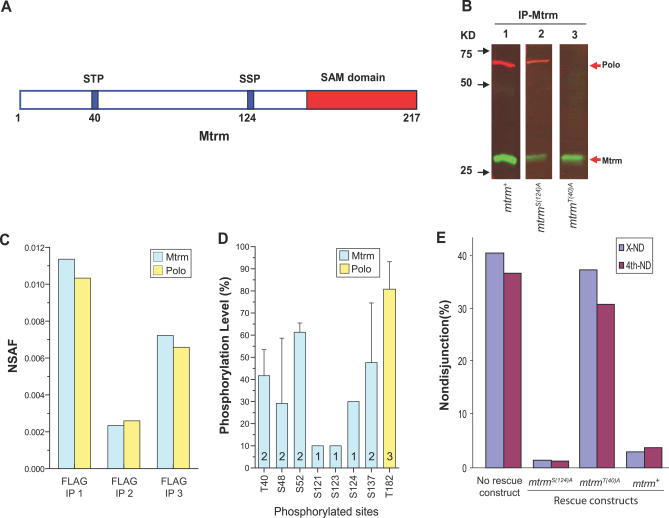
Mtrm Physically Interacts with Polo with a Stoichiometry of Approximately 1:1(A) Schematic depiction of the Mtrm protein. Mtrm has two potential PBD-binding sites, STP and SSP, with the central serine/threonine residue at 40 and 124, respectively, and a SAM domain at the C terminus. Two independent transgenes expressing mutated PBD-binding sites were generated: MtrmT(40)A, which disrupts the STP site and MtrmS(124)A, which disrupts the SSP site.(B) Mtrm and Polo physically interact as shown by coimmunoprecipitation experiments. An antibody to Mtrm precipitates Polo from wild-type ovary extracts (lane 1). Expression of the mutated PBD binding site constructs in a mtrm null background reveals that MtrmS(124)A does not ablate the Mtrm-Polo interaction (lane 2); however, MtrmT(40)A failed to bind Polo (lane 3), indicating that the STP motif is critical for the Mtrm-Polo interaction.(C) Three independent affinity purifications from ovarian extracts expressing a C-terminally 3× FLAG-tagged Mtrm were used for the MudPIT mass spectrometry assay. Among the reproducible and significant (p-value < 0.001) proteins identified in all three analyses, Polo was detected by multiple peptides and stands out as the only protein recovered at levels similar to those of Mtrm, as estimated by NSAF.(D) Phosphorylated sites detected in Mtrm (blue bars) and Polo (yellow bar) are shown. Modification levels are estimated based on local spectral count and averaged across the three immunoprecipitations. The underlined numbers in each bar represent the number of times (out of three) the residues were found modified.(E) The STP site required for Polo binding is also required for Mtrm function. As noted above, FM7/X; mtrm/+ heterozygotes display approximately 40% X nondisjunction (ND) and 37% 4
th nondisjunction. Although the MtrmS(124)A protein was able to rescue the meiotic defect (3.6% X and 4.4% 4
th ND), the MtrmT(40)A protein displayed similar levels of nondisjunction as mtrm/+ heterozygotes, indicating that the STP motif is critical for Mtrm function. The finding that only the STP site is required for both Mtrm function and the binding of Mtrm to Polo is consistent with the observation that only the STP motif is conserved across all twelve sequenced Drosophila genomes, whereas the SSP motif is conserved only within the six species that belong to the D. melanogaster–D. ananassae clade.